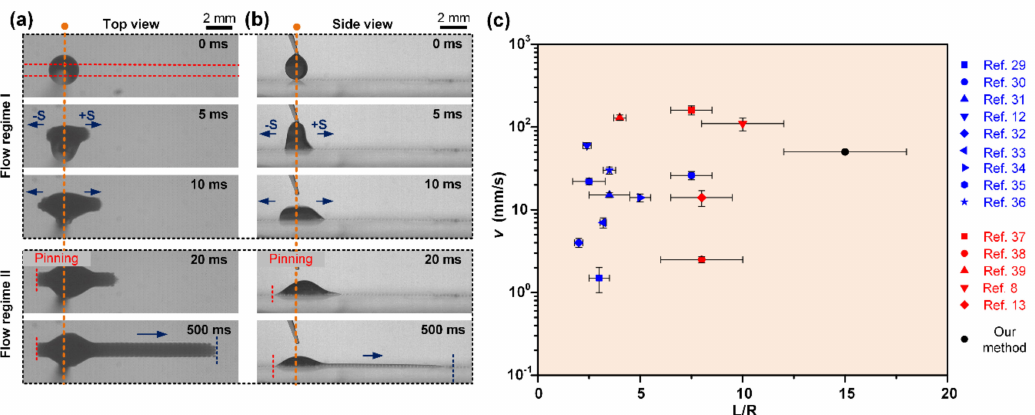
Figure 2. In situ observation of liquid transport behavior on STC channel from ( a ) the top view and ( b ) the side view. The liquid transport can be identified as two flow regimes: Flow regime I: bidirectional spreading; Flow regime II: unidirectional spreading. The red and orange dashed lines denote the hydrophobic boundary and the position of dripping liquid, respectively. ( c ) Comparison of spreading velocity and normalized distance L / R (L is the transport distance of a droplet in the forward direction and R is the droplet radius) among di ff erent surfaces with gradient (blue symbols) or patterned (red symbols)